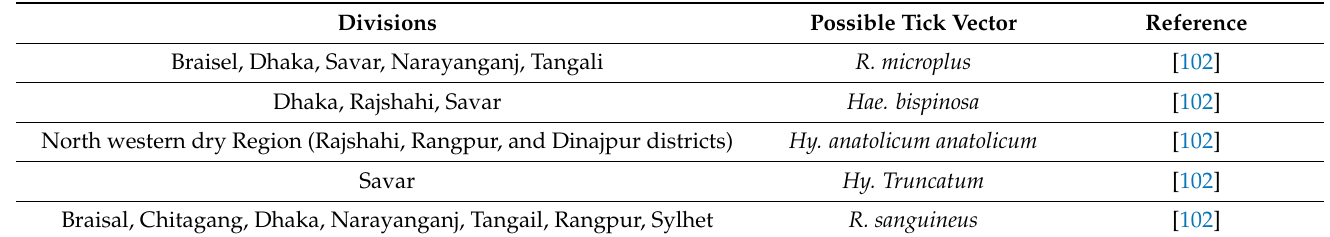
Table 7. Distribution of possible tick vectors for Theileria species in various regions of Bangladesh. Divisions